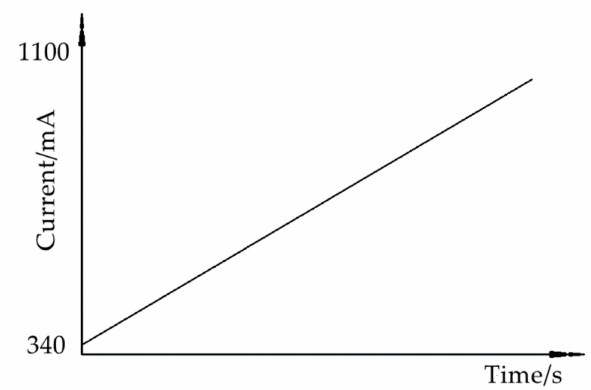
Figure 4. Input current signal of proportional electromagnet.